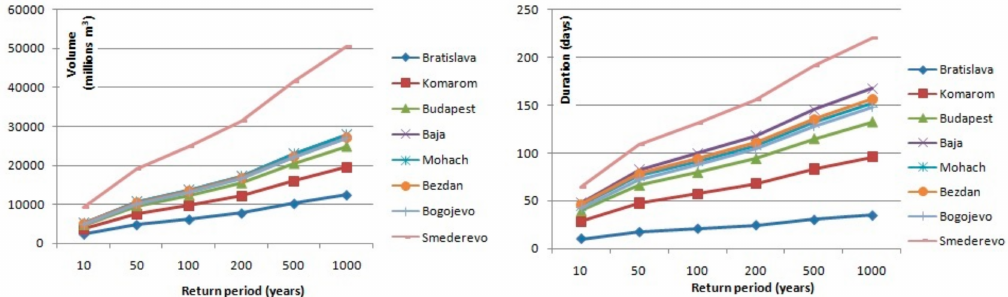
Figure 6. Flood volumes and duration of Danube River in the Pannonian